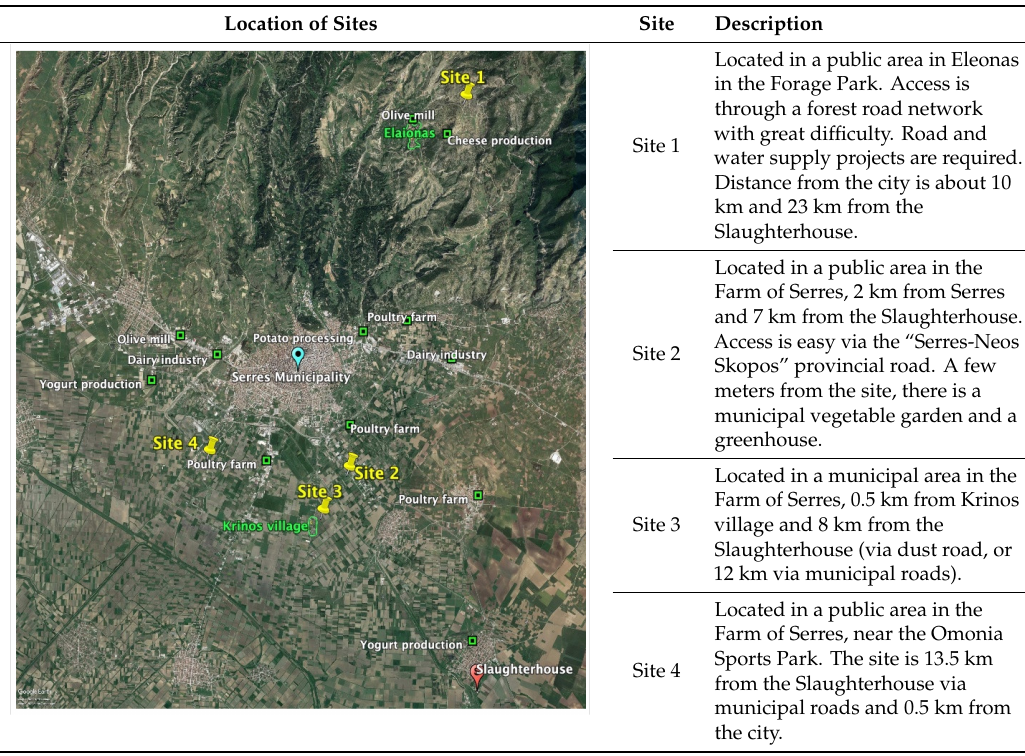
Table 1. Alternative locations for UABT development in the area under study.